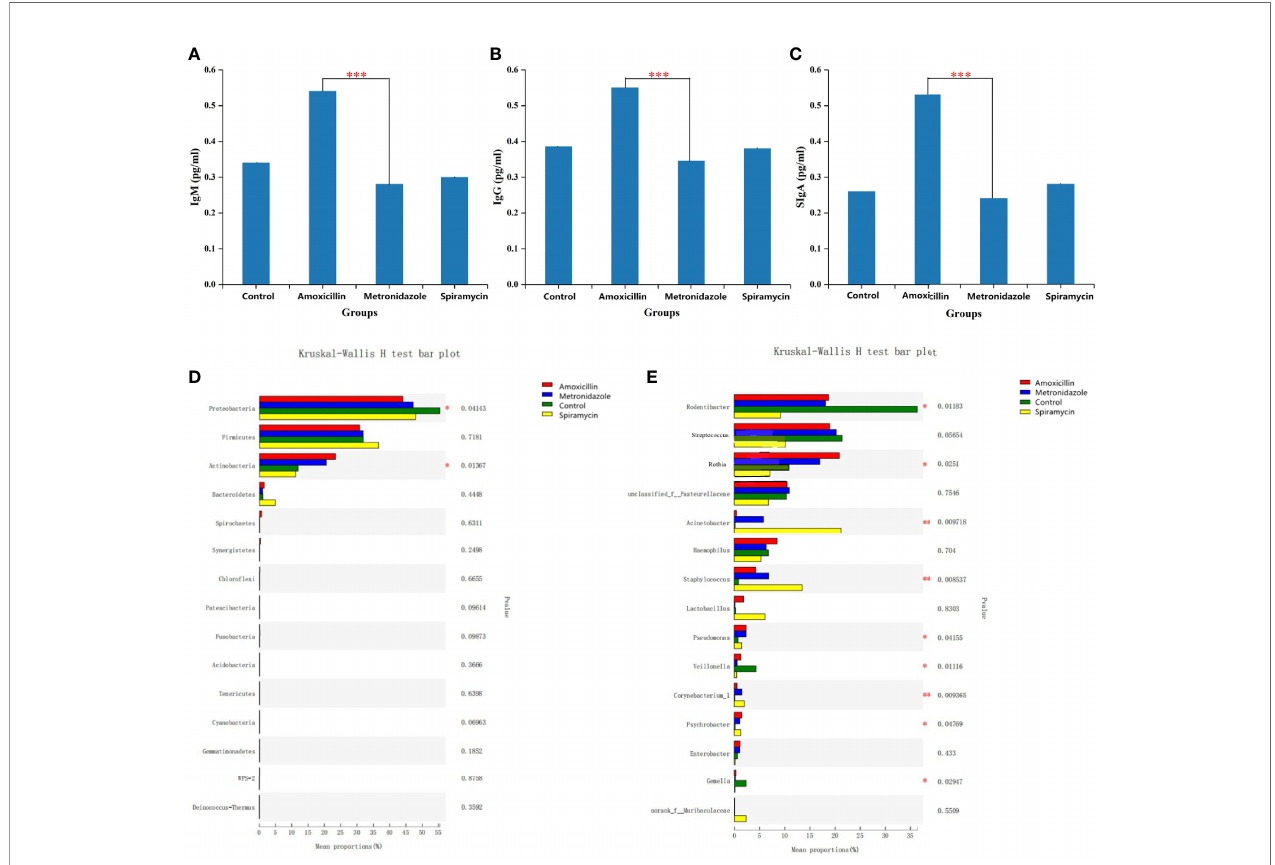
FIGURE 2 | Statistical comparison of the ELISA experimental results (A – C) and relative abundance (D, E) of rats oral microbiota among the four groups. (A – C) SIgA,IgM,IgG content in all samples. (D) Comparison of dominant phyla in all groups. (E) Comparison of dominant genera in all the groups. Differences were considered statistically signi fi cant at *p<0.05; **p<0.01; ***p<0.001